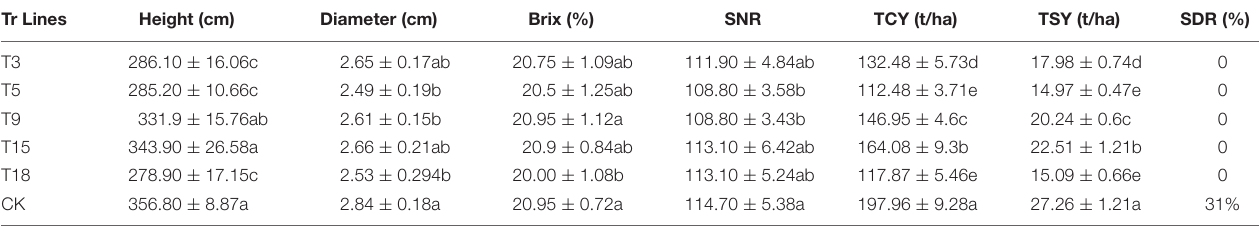
TABLE 3 | Agronomic characteristics, industrial traits, and the stalk borer damage percentage in single-copy transgenic lines and the control lines. Tr Lines